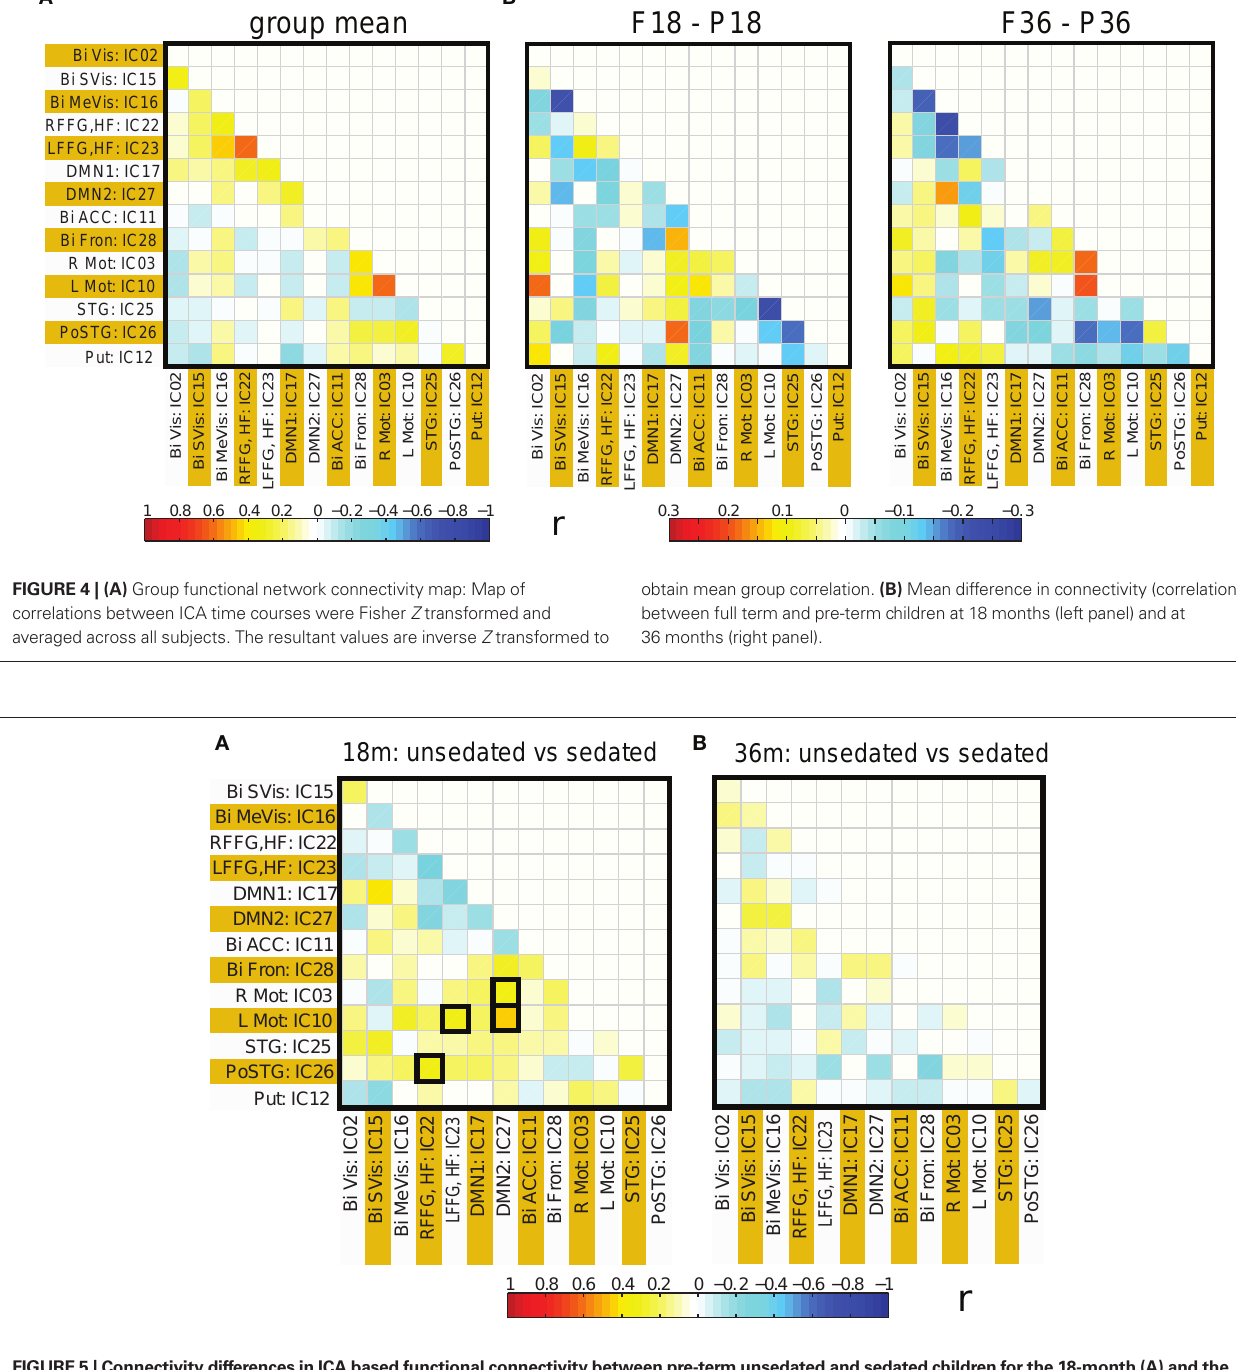
Figure 5 | Connectivity differences in iCA based functional connectivity between pre-term unsedated and sedated children for the 18-month (A) and the 36-month (B) groups. The cells with significant connectivity differences ( p < 0.05 after FDR correction) are enclosed in black squares. No significant differences were observed for the 36-month